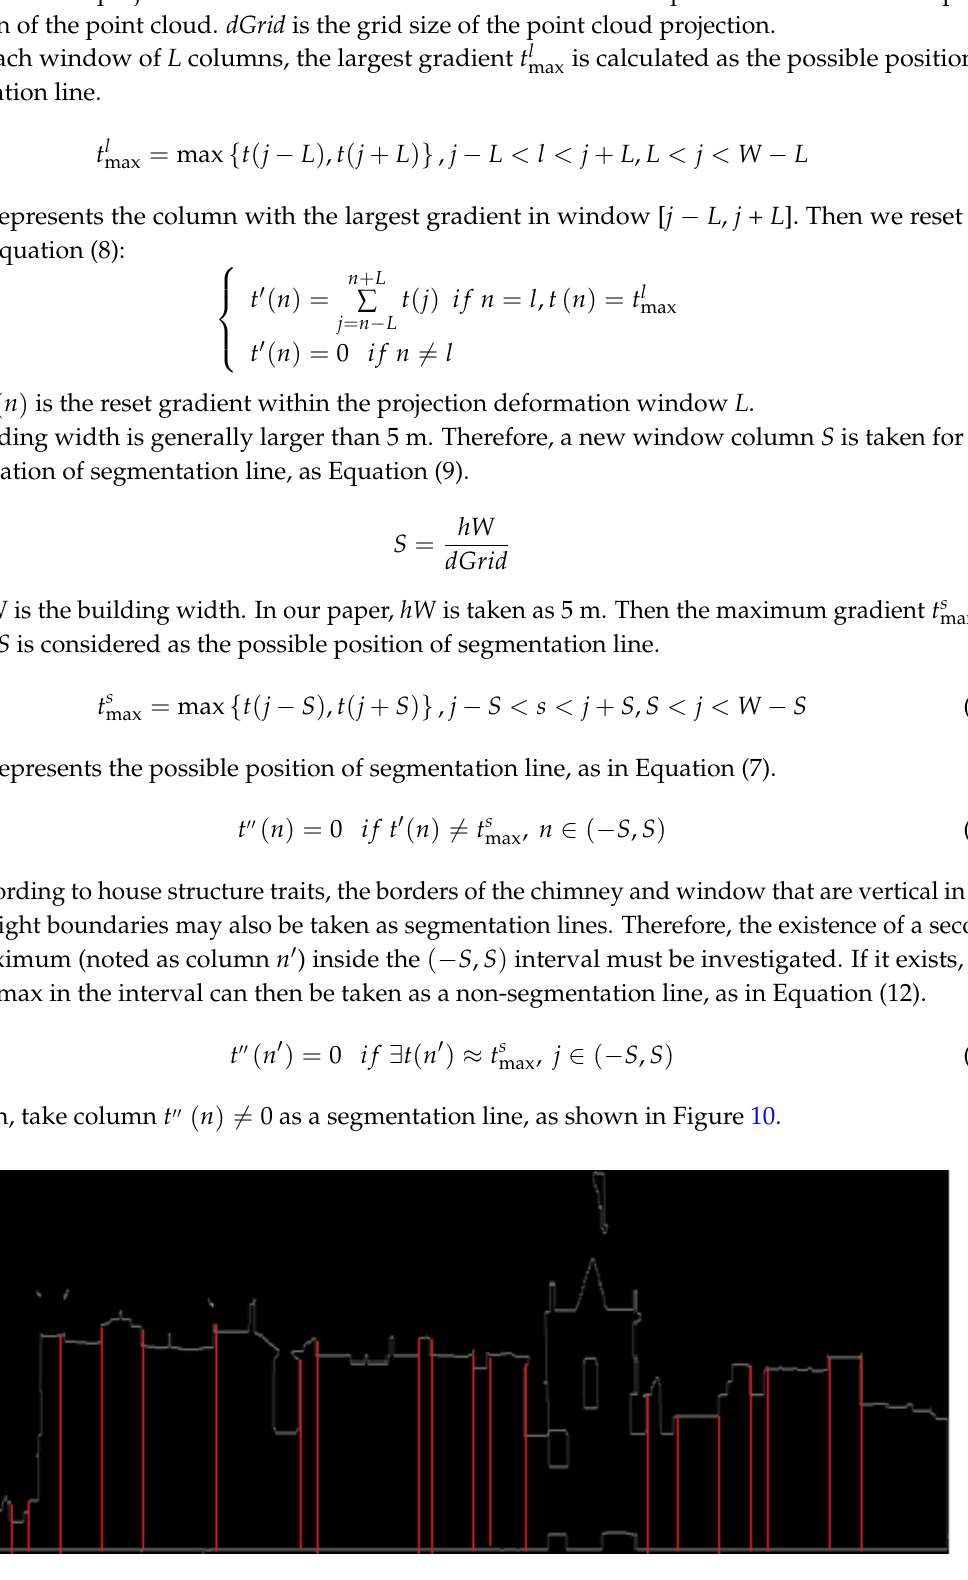
Figure 10. Result of segmentation line calculation.